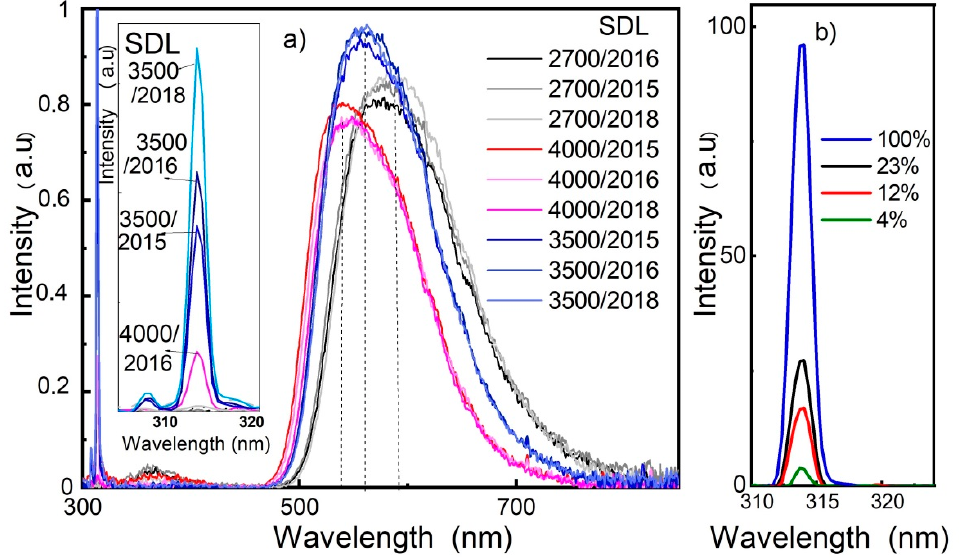
Figure 8. ( a ) CL spectra in SDL phosphors; ( b ) dependence of the band intensity at 312 nm on the excitation power in SDL 3500 phosphor. The maximum energy density per pulse was 350 mJ/cm 2 .